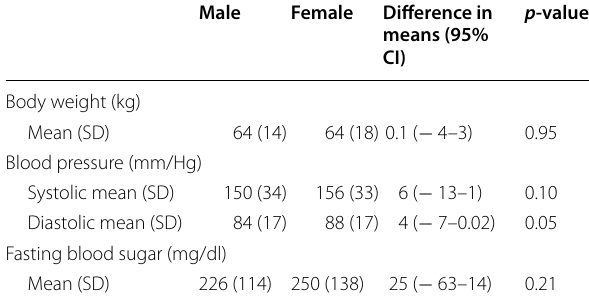
Table 2 Body weight, blood pressure and fasting blood glucose parameters of male and female